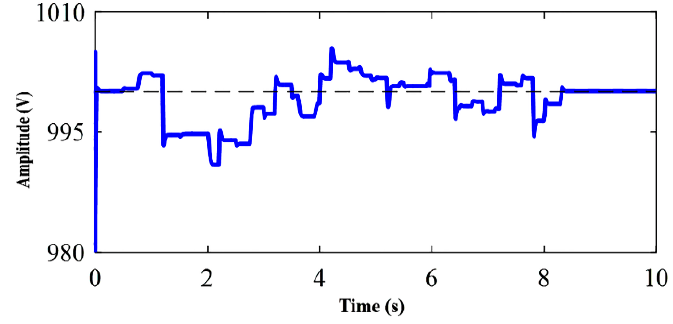
Figure 9. Dc bus voltage in the presence of SDRE controller.